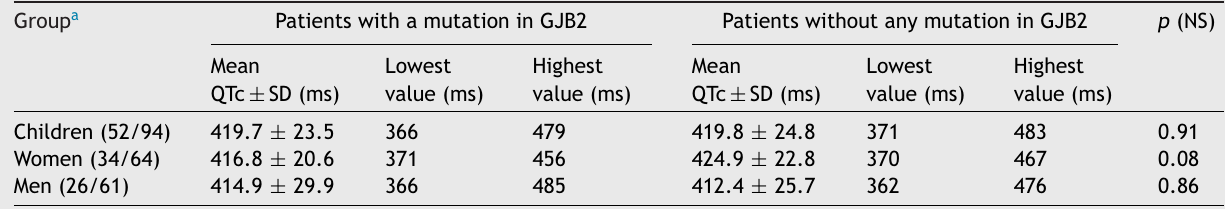
Findings of QTc interval in the ECG study population.